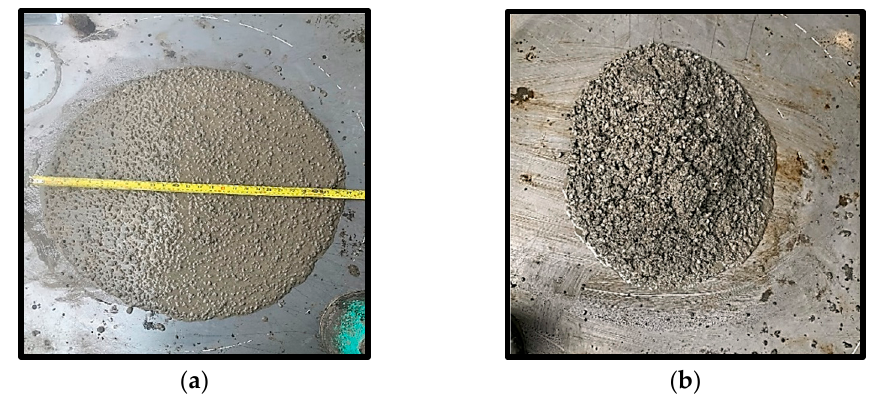
Figure 5. Slump flow for ( a ) mix FA25CR7.5NS0 and ( b ) mix FA10CR15NS0.